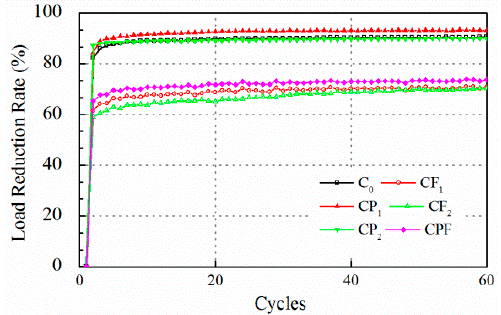
Figure 8. Load reduction rate at 0.2 mm crack